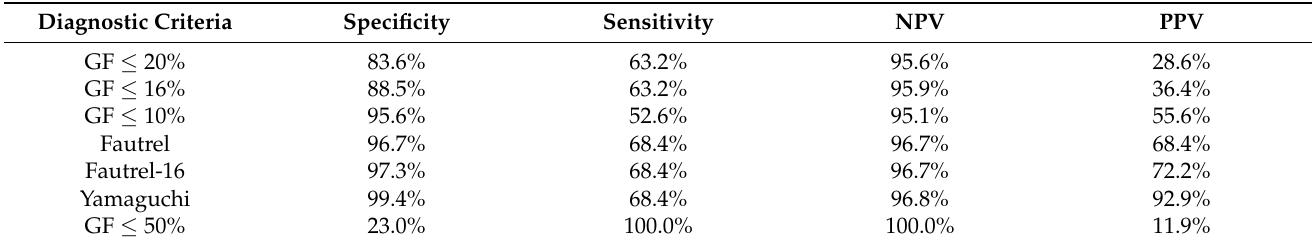
Table 3. Diagnostic value of glycosylated ferritin and classification criteria in adult-onset Still’s